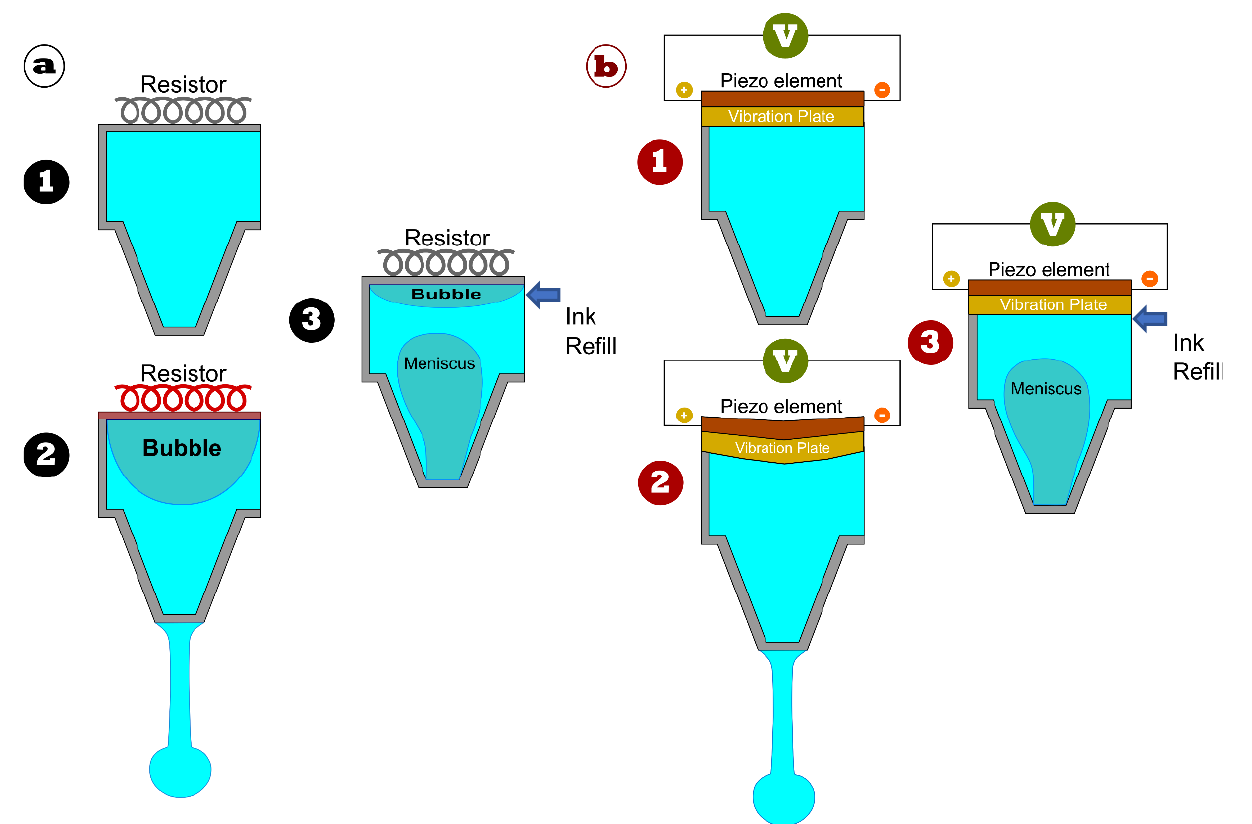
Figure 2. ( a ) Thermal inkjet printing process: (1) Ink in a stable form in the chamber. (2) The resistor heats up and evaporates the fluid, forming a bubble, and the pressure forces the ink outward from the nozzle cavity. (3) Turning off the resistive heating causes the bubble to subsequently collapse, and a reduction in pressure sucks in the ink both from the nozzle and the ink refill inlet. ( b ) Piezoelectric printing process (1–3): a similar process as thermal inkjet printing, except here the pressure produced by the piezo element/vibration plate combination stimulates the inkjet and ink refill pro- cess.